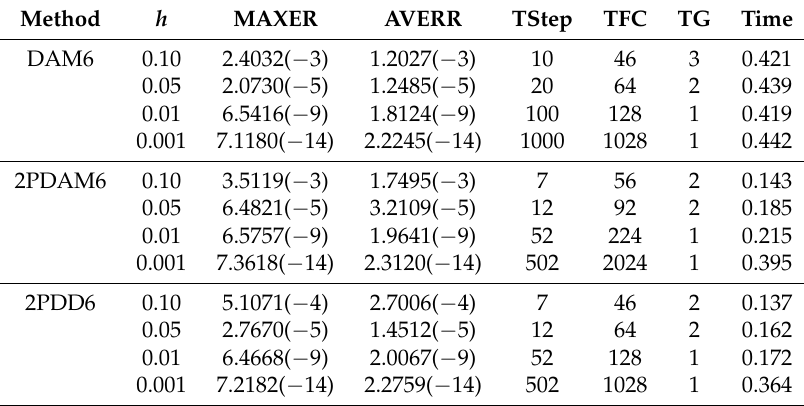
Table 4. Results for solving Test Problem